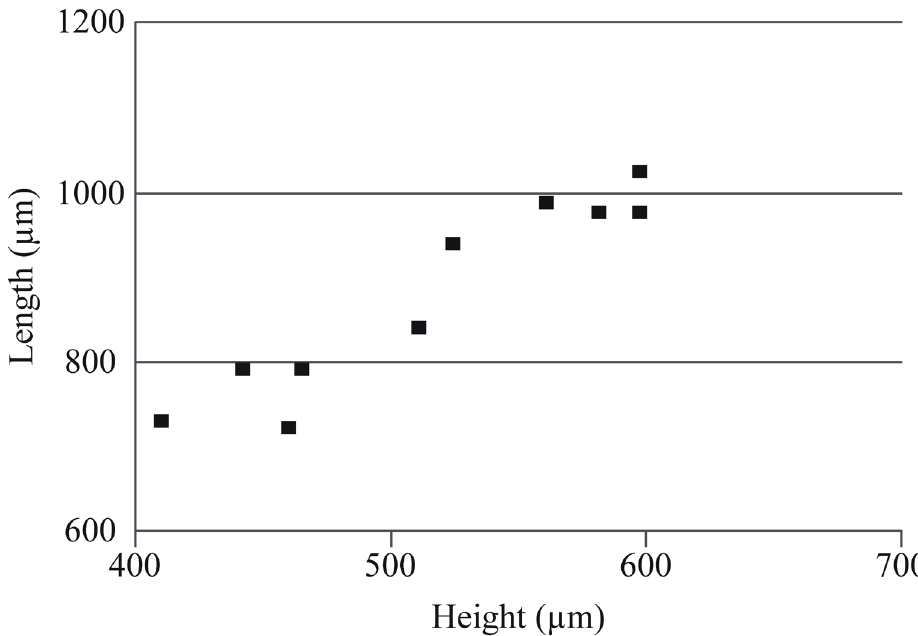
Fig. 6. Height/length diagram of Bairdia jeromei sp.